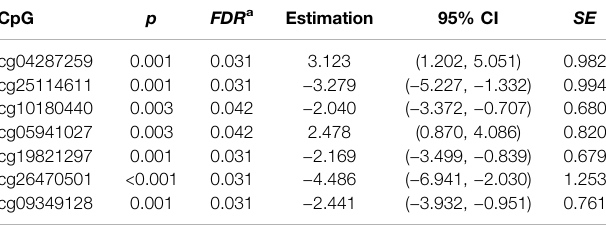
TABLE 3 | The correction p -value of de-sparsifying the LASSO